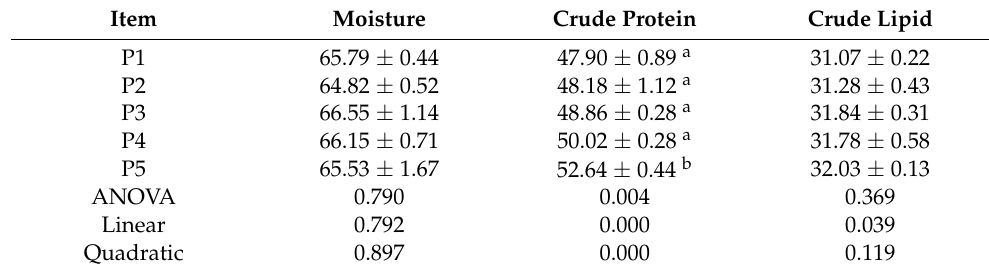
Table 4. The whole-body composition of Oncorhynchus mykiss fed experimental diets (% wet weight